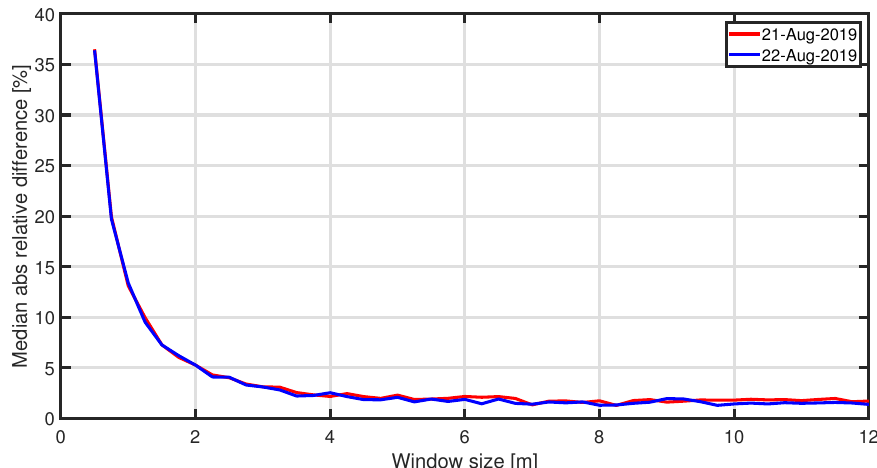
Figure 7. RMSH median relative difference between HR and LR images for the two analysed days when considering different window size, for window size moving from 0.5m to